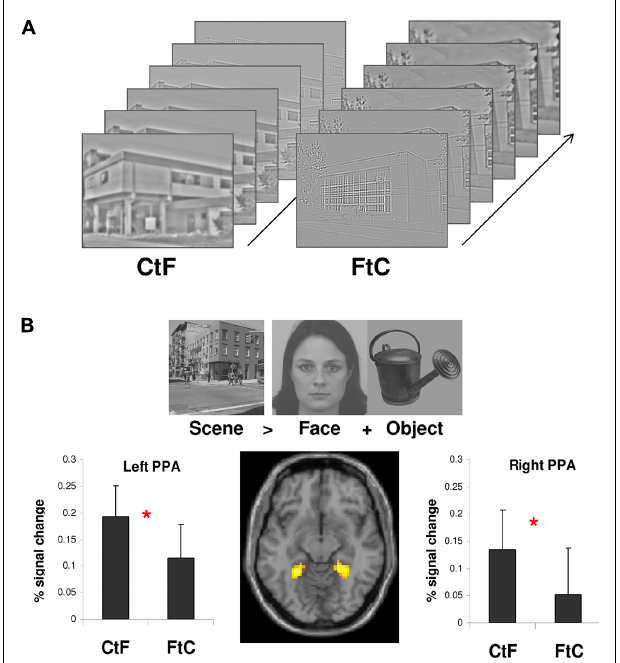
FIGURE 5 | (A) Six spatial frequency filtered images of scenes that depict a coarse-to-fine (CtF) and fine-to-coarse (FtC) sequences. (B) Parahippocampal place area (PPA) localized by contrasting the activation induced by the perception of scenes to those induced by the perception of faces and objects. Signal changes relative to the global mean intensity of signal were then extracted from the PPAs for each sequence (CtF and FtC). PPA showed stronger activation during the CtF than FtC categorization of sequences. Error bars indicate 95% Confidence Intervals. * Indicate significant differences. Figure adapted from Musel etal.